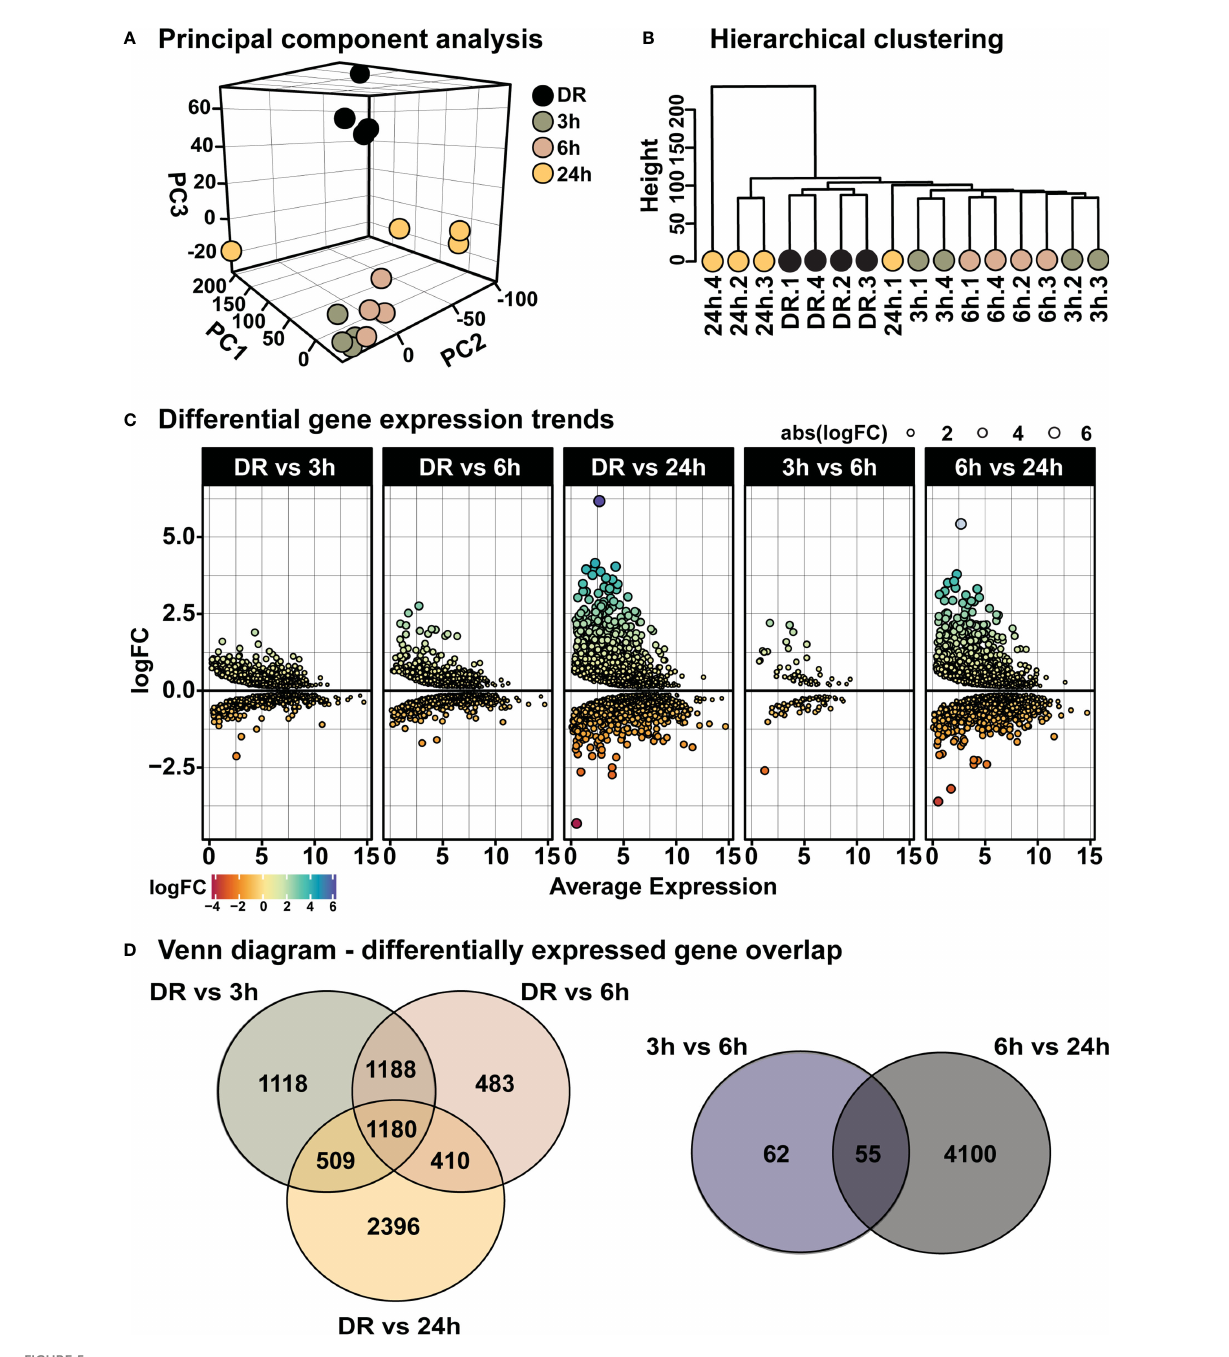
FIGURE 5 Distinct transcriptomic pro fi les in the retina following short exposure to photo-oxidative damage. (A) PCA shows between-group clustering, with some within-group variation shown at 24h-PD. These clustering pro fi les can also be shown by (B) hierarchical clustering. (C) Differential gene expression analysis shows distinct gene expression pro fi les at each time-point. (D) Venn diagrams show unique and shared differentially expressed genes at each time-point comparison. Differentially expressed genes determined by FDR < 0.05, FC > 1.5. n =